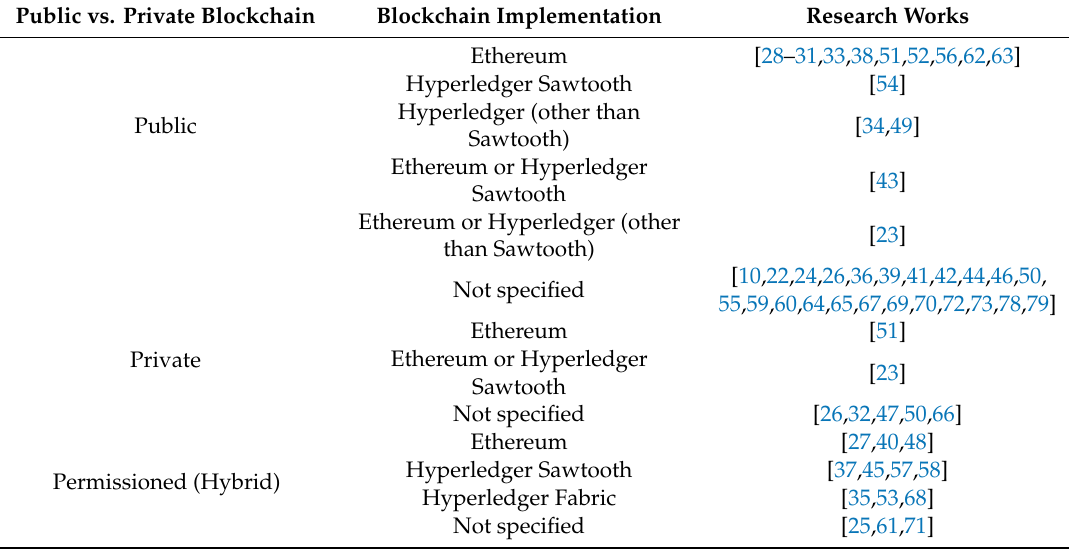
Table 2. Literature survey—use of di ff erent blockchain types and implementations in agriculture traceability